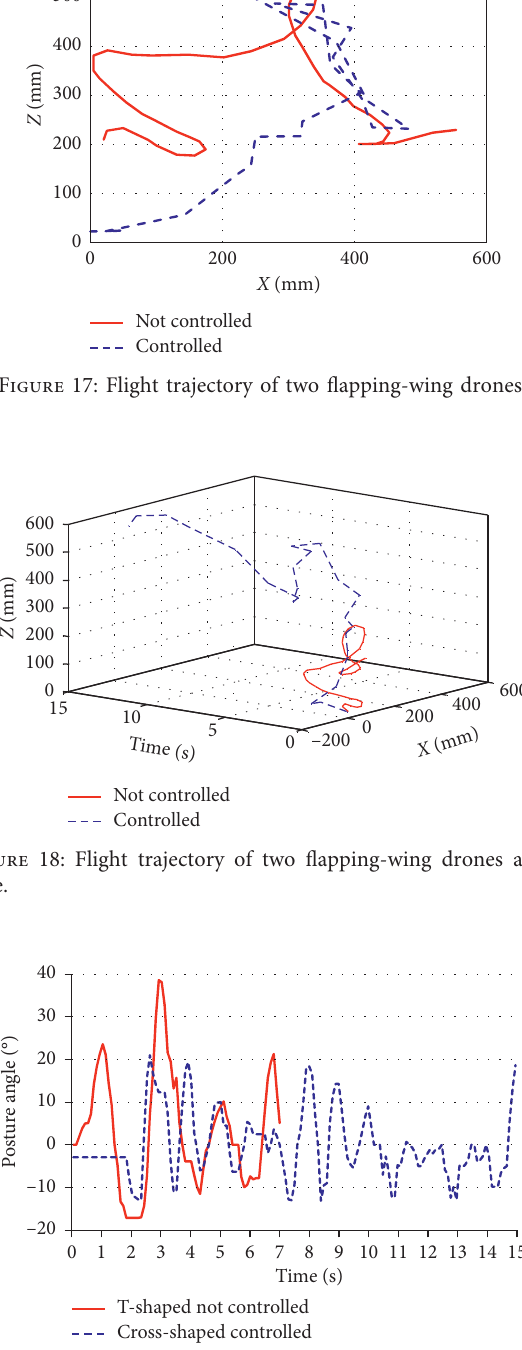
Figure 19: Posture angle curve of flight